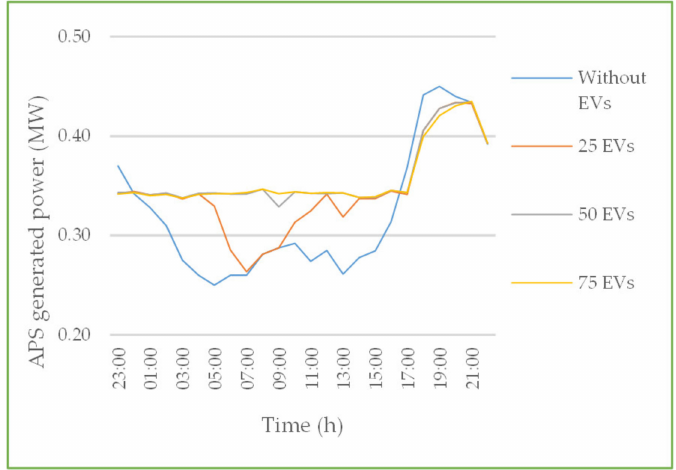
Figure 15. APS output required in the presence of a 140.0 kWp PV plant for test case 4 and LC1.